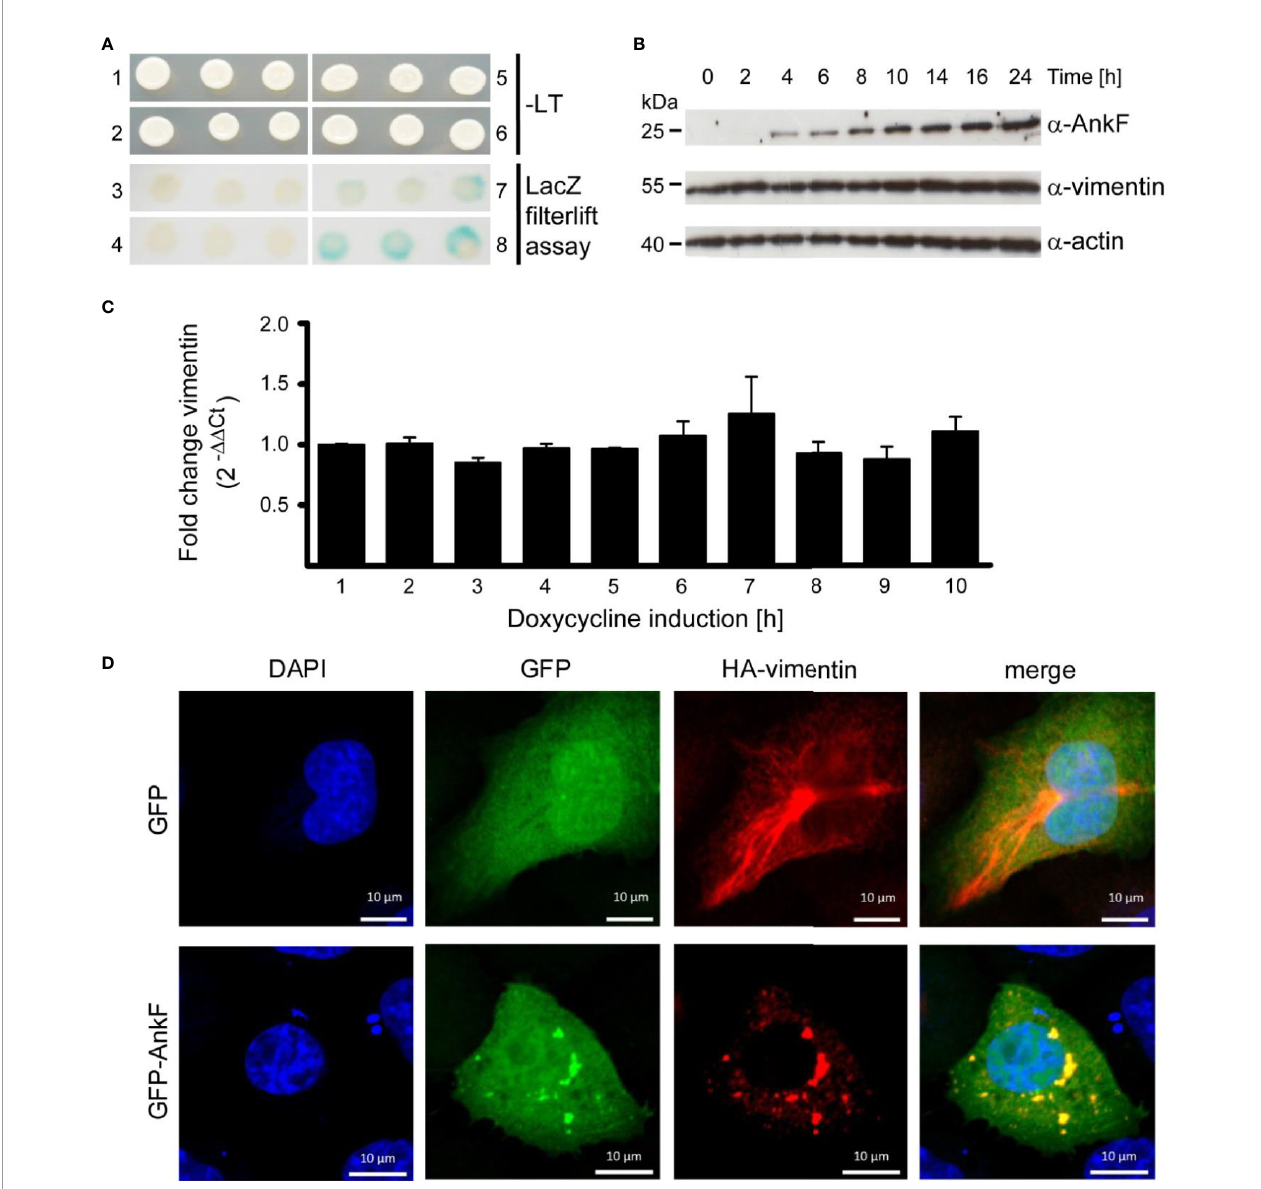
FIGURE 7 | AnkF binds the type III intermediate fi lament vimentin. (A) A yeast-two-hybrid assay was performed with the Matchmaker Gold Yeast Two-Hybrid System (Clontech) and a HeLa cDNA library. Recombinant, leucine-tryptophan auxotrophic yeast Y190 were grown on SCAD agar plates in the absence (1, 2, 5 and 6) and presence of leucine and tryptophan and X-Gal (3, 4, 7 and 8). (1 and 3) Recombinant yeast carrying the empty vector pGADH with the GAL4 activation domain and the vector pGBT encoding ankF fused to the GAL4 binding domain. (2 and 4) Recombinant Y190 carrying the empty vector pGBT and the vector pGADH-vimentin. (5 and 7) Recombinant Y190 carrying the vector p53pBD and vector pSV40-pAD-gal4 containing the large T-antigen of the SV40 virus fused to the Gal4 activation domain as positive control interaction partners. (6 and 8) Recombinant Y190 carrying the vector pGBT9-ankF and the vector pGADH-vimentin. The image is representative of three independent experiments. (B, C) Stably-transfected HeLa-AnkF cells (HeLa-pWHE644/655-AnkF), harboring a doxycycline- inducible AnkF-expression system, were incubated without or with 1 µg/ml doxycycline for the indicated durations. (B) Cell lysates were separated by SDS-PAGE, transferred to a PVDF membrane, and probed with antibodies against AnkF, vimentin and actin as loading control. A representative image of three independent experiments is shown. (C) Total isolated RNA was reverse-transcribed using SuperScript II reverse transcriptase according to the manufacturer ’ s protocol and a qRT-PCR was performed with primers speci fi c for vimentin (936 and 937) and actin (827 and 828) as a housekeeping gene. Vimentin was normalized to actin and is depicted as fold change compared to non-induced cells. (D) CHO-FcR cells were transiently transfected with plasmids pCMV-HA-vimentin (red) together with pGFP (green) alone (upper panel) or together with pEGFP-AnkF (lower panel). 24 h post-transfection, cells were fi xed and HA-vimentin was stained with speci fi c antibodies by indirect immuno fl uorescence (red). Nuclei were stained with DAPI (blue). Transient expression of HA- and GFP-containing proteins was visualized by epi fl uorescence microscopy. Images are representative of three independent